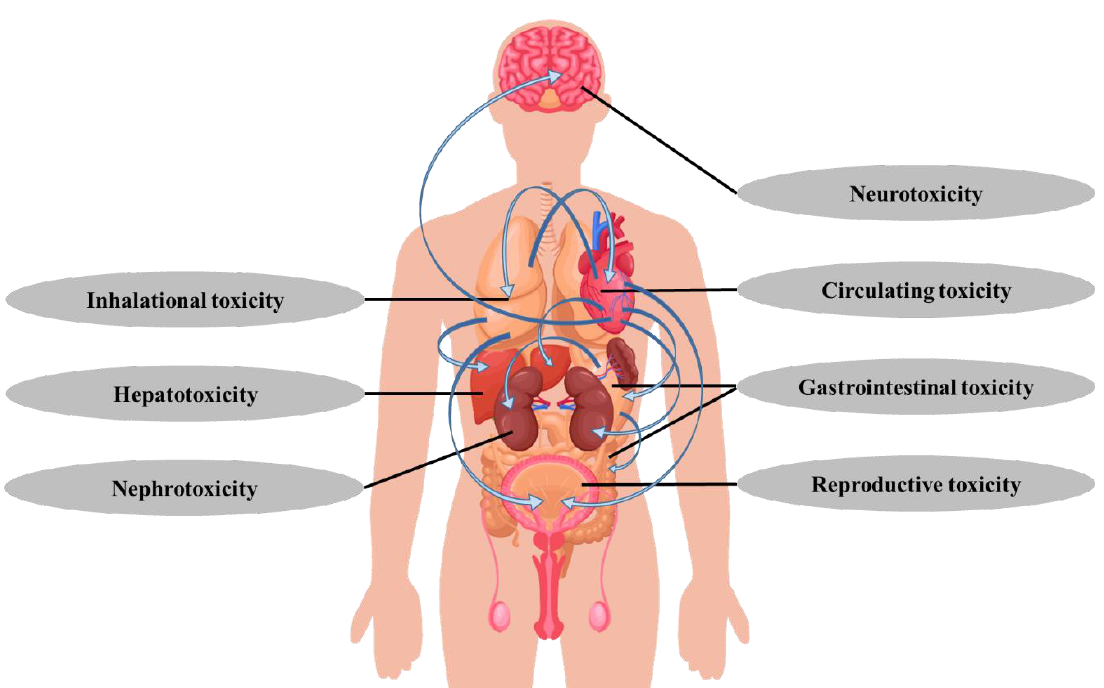
Figure 2. Toxic effects of atmospheric microplastics on different organs and systems.